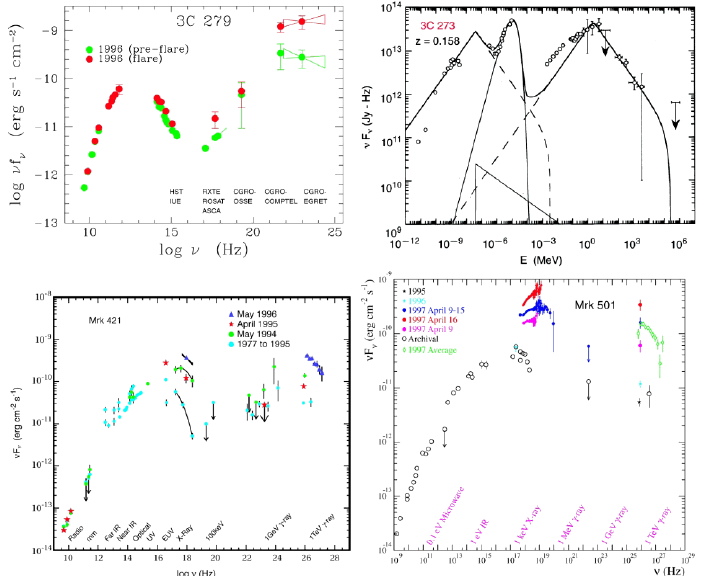
Figure 1. Two-hump multi-wavelength spectra of LSP (3C279 and 3C273) and HSP (Mrk 421 ans Mrk 501) blazars. In 3C273 case the thermal contribution of disk in optical-UV band is also visible. Credit: A.E. Wehrle/M.A. Catanese/J.H. Buckley/Whipple